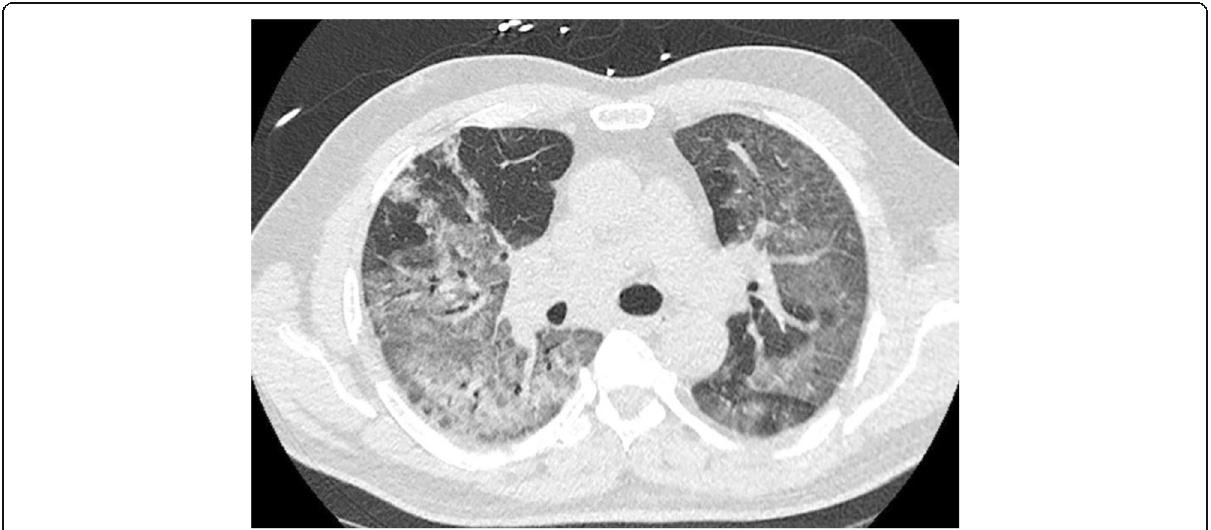
Fig. 1 Chest computed tomography showing diffuse bilateral ground-glass opacities with limited